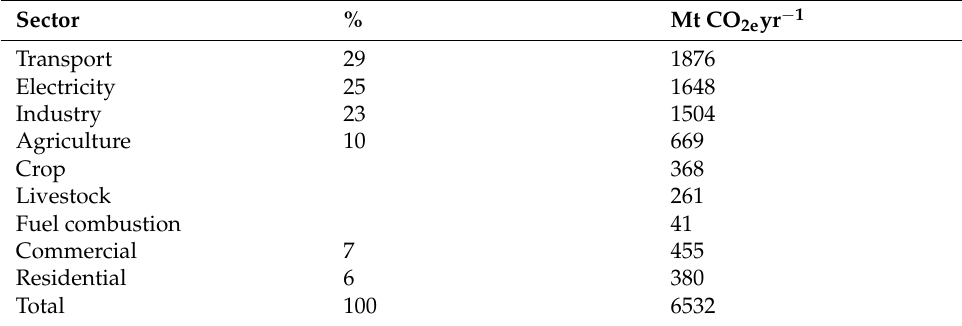
Table 3. Greenhouse gas emissions by economic sector in the US for 2019